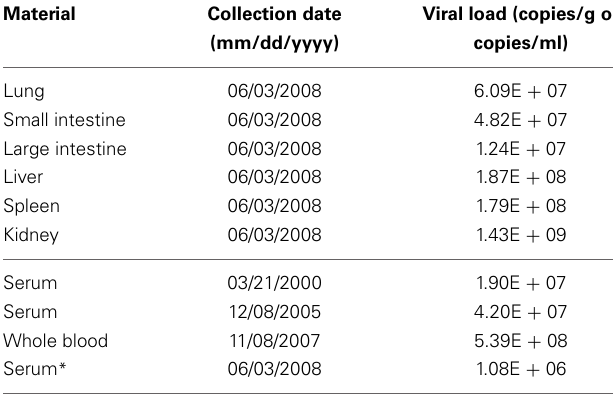
Table 2 | Sl.L-PV-1 loads determined in different organs (collected at necropsy in 2008) and from serum/blood samples collected during various